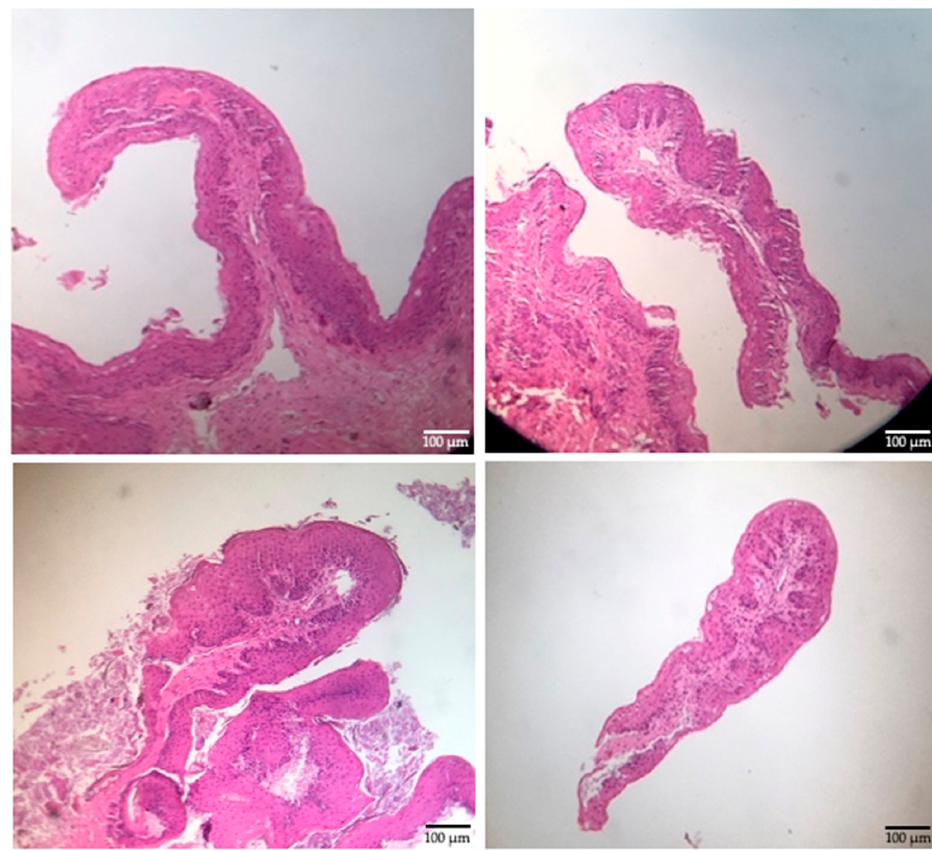
Figure 4. Rumen epithelial samples (10 ×